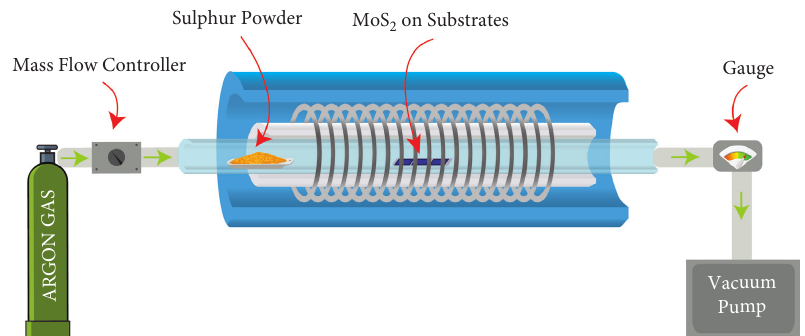
Figure 2: Schematic diagram of MoS 2 growth using the chemical vapor deposition (CVD)